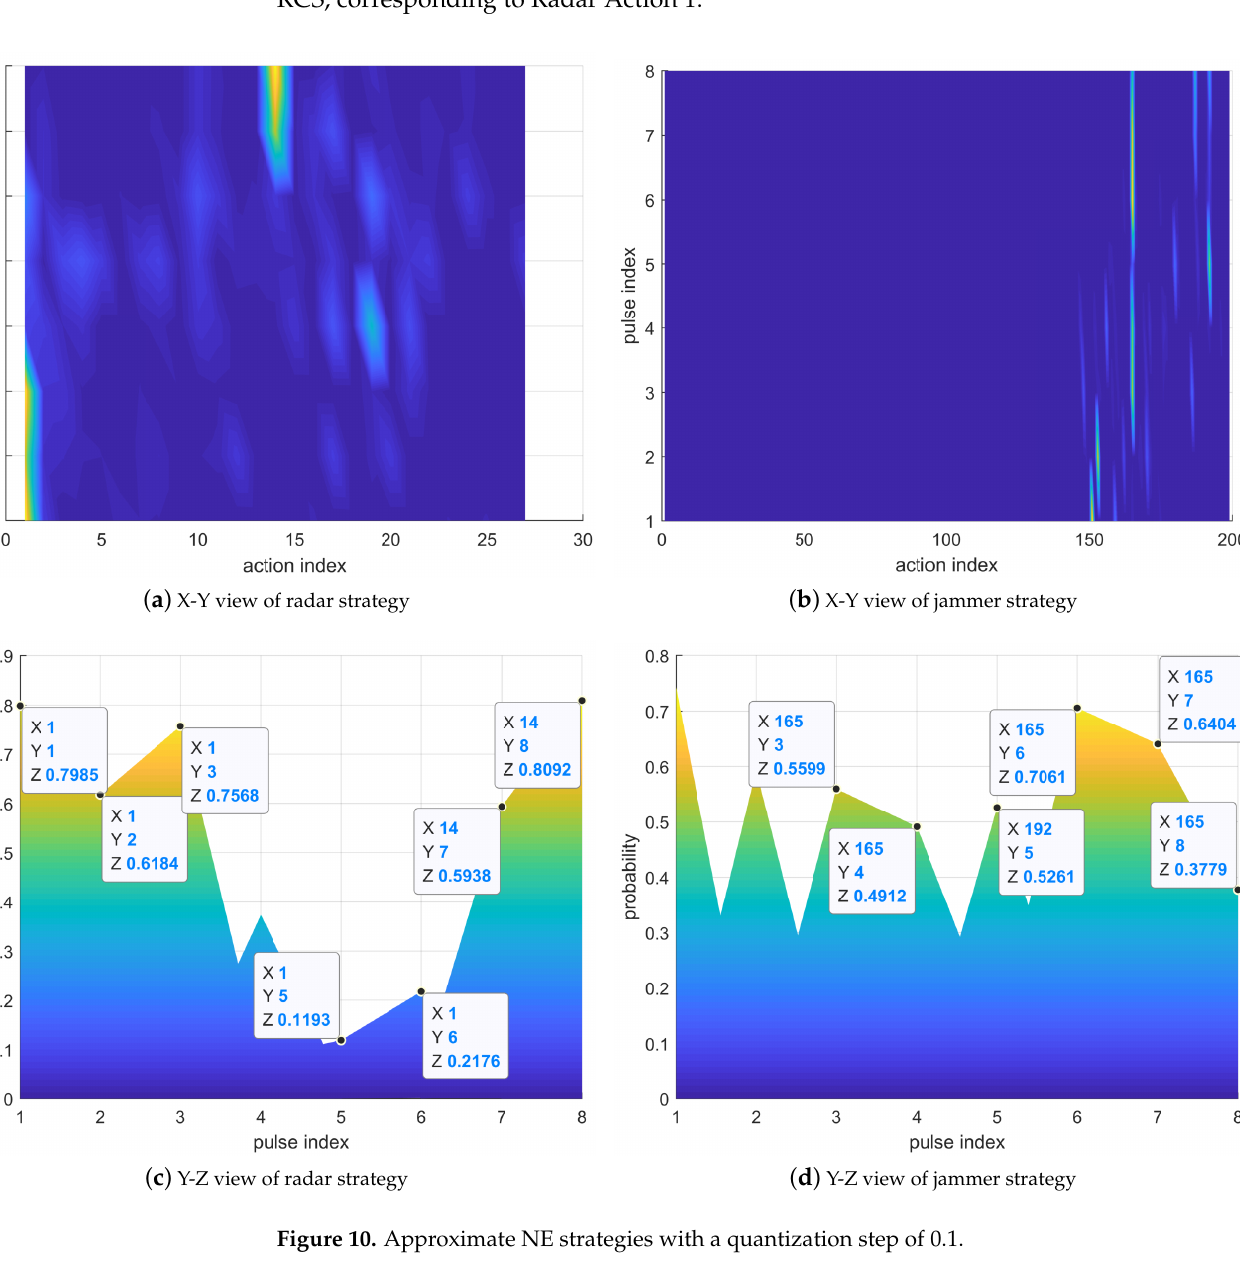
smallest. The jamming power of f 0 and f 1 is the same, but the RCS of f 0 is the largest. output